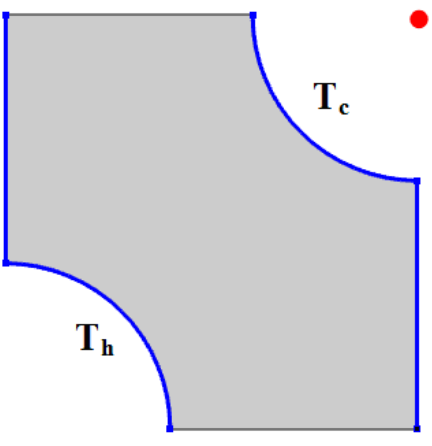
Figure 1. System Figure 1. System description. Table 1. Thermophysical properties of the fluid and the magnetic particles.